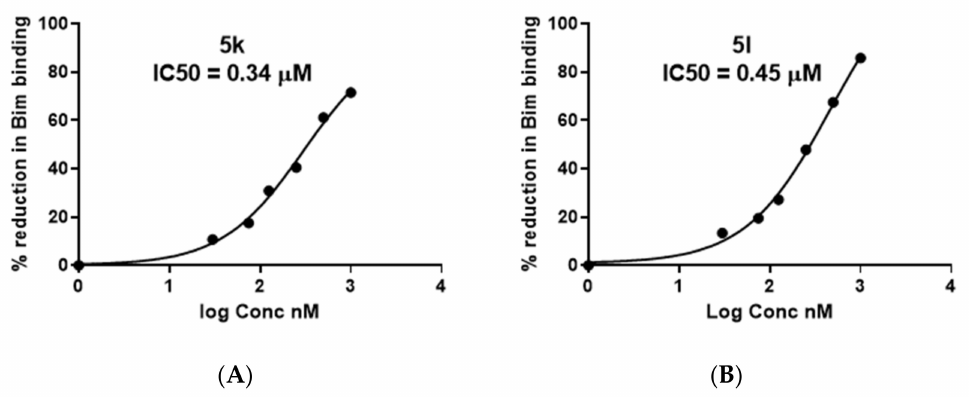
Figure 2. Inhibition activity of the most active compounds ( 5k and 5l ) against Bcl-2-Bim binding. ( A ) IC 50 calculation of 5k . ( B ) IC 50 calculation of 5l